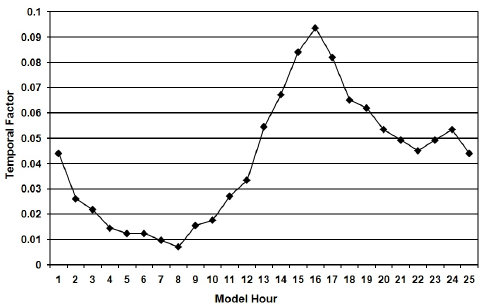
Figure A7. Hourly temporal profile derived from the diel variability of ClNO 2 provided in Osthoff et al. (2008). This was applied to perform hourly allocations for the representative day of emissions created for oceanic ClNO 2 . NOTE: See caveat mentioned in our conclusions.